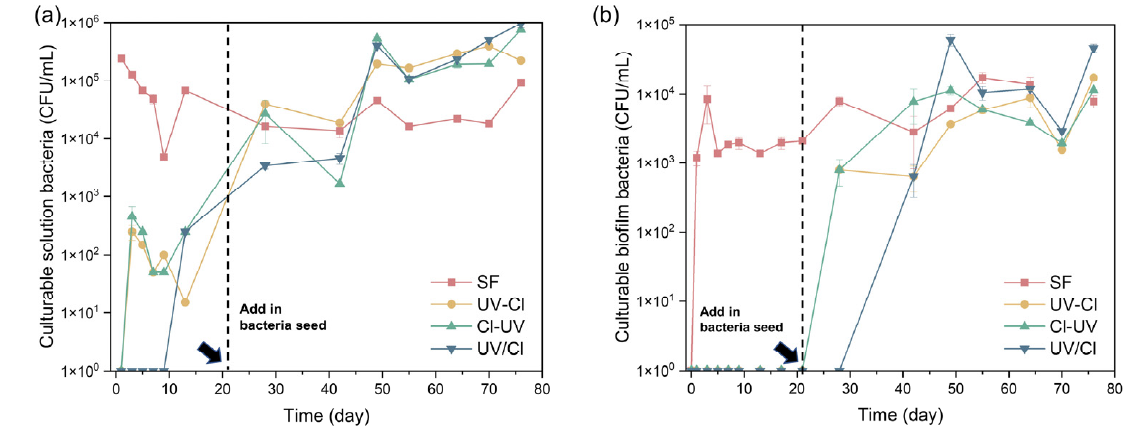
Figure 4. Culturable bacteria number in solution ( a ) and biofilm ( b ) in the reactors running without bacteria seed up to 21 days.